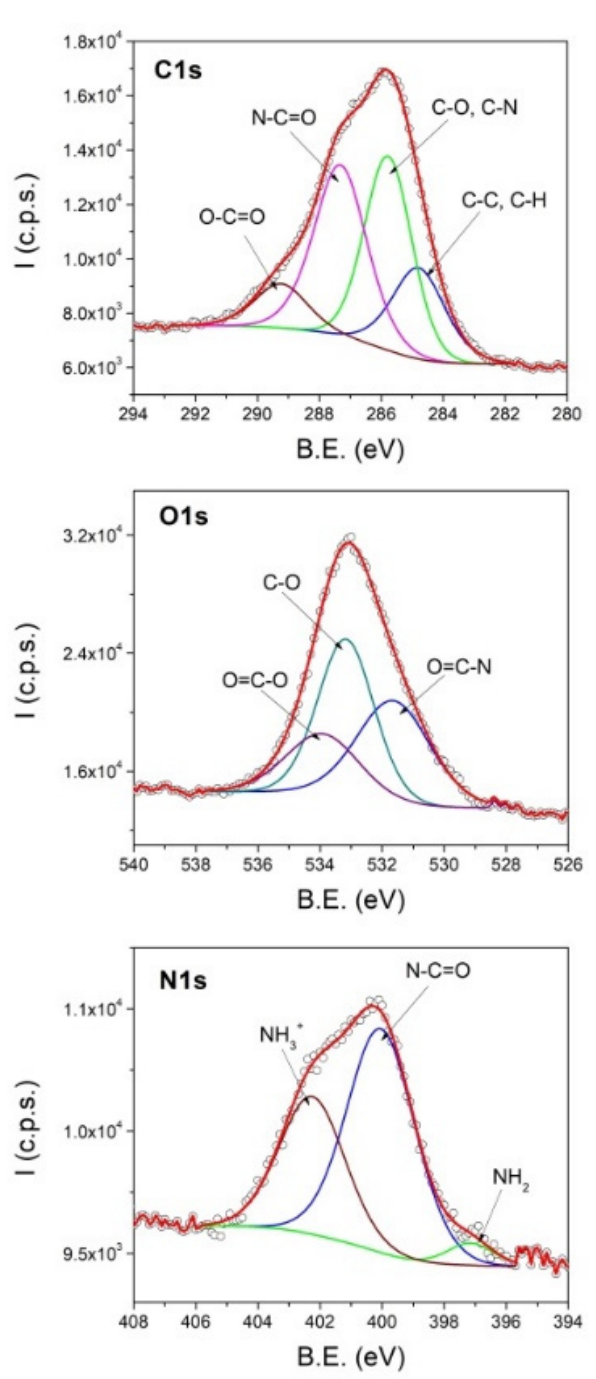
Figure 18. High resolution XPS spectra of C1s, O1s and N1s core levels from CHIT-PAAA . The adsorption of Pb on CHIT-PAAA is evidenced by the high-resolution XPS spectra shown in Figure 19. The Pb spectrum from Figure 19 exhibits the doublet Pb4f5/2 and Pb 4f7/2 located at 143.7 eV and 138.8 eV, corresponding to Pb. A comparison of the XPS spectra from Figures 18 and 19 shows changes in the relative intensities of the component peaks, especially for O1s and N1s. This fact suggests that the mechanism of Pb adsorption on CHIT-PAAA involved the interaction of O and N atoms with metallic